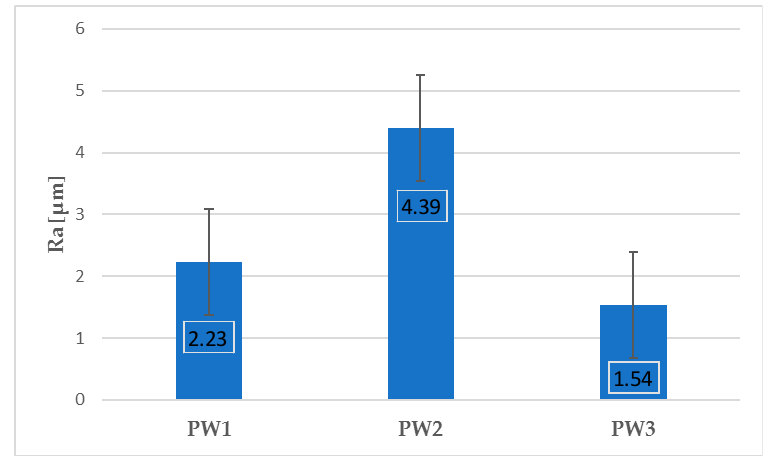
Figure 6. Comparison of average surface roughness (Ra) of PW1, PW2, and PW3 samples.